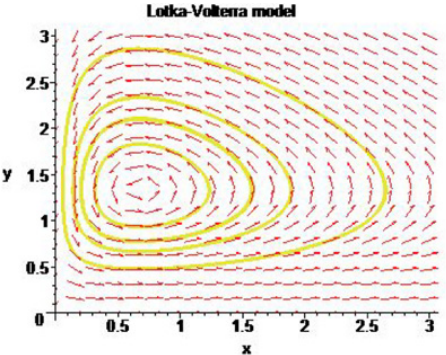
Figure 2. Trajectory of the solution in phase space.